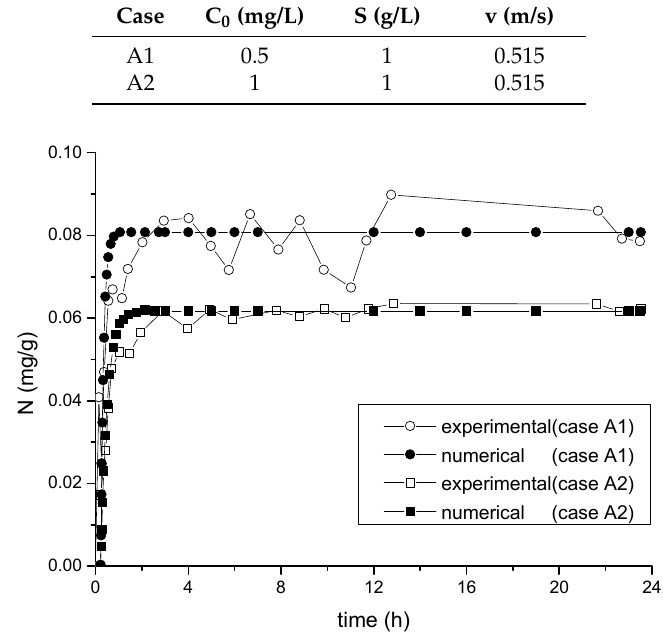
Table 2. The initial phosphorus concentration C 0 , initial sediment concentration S, and the cross-sectional average velocity v of different cases in the numerical simulations.